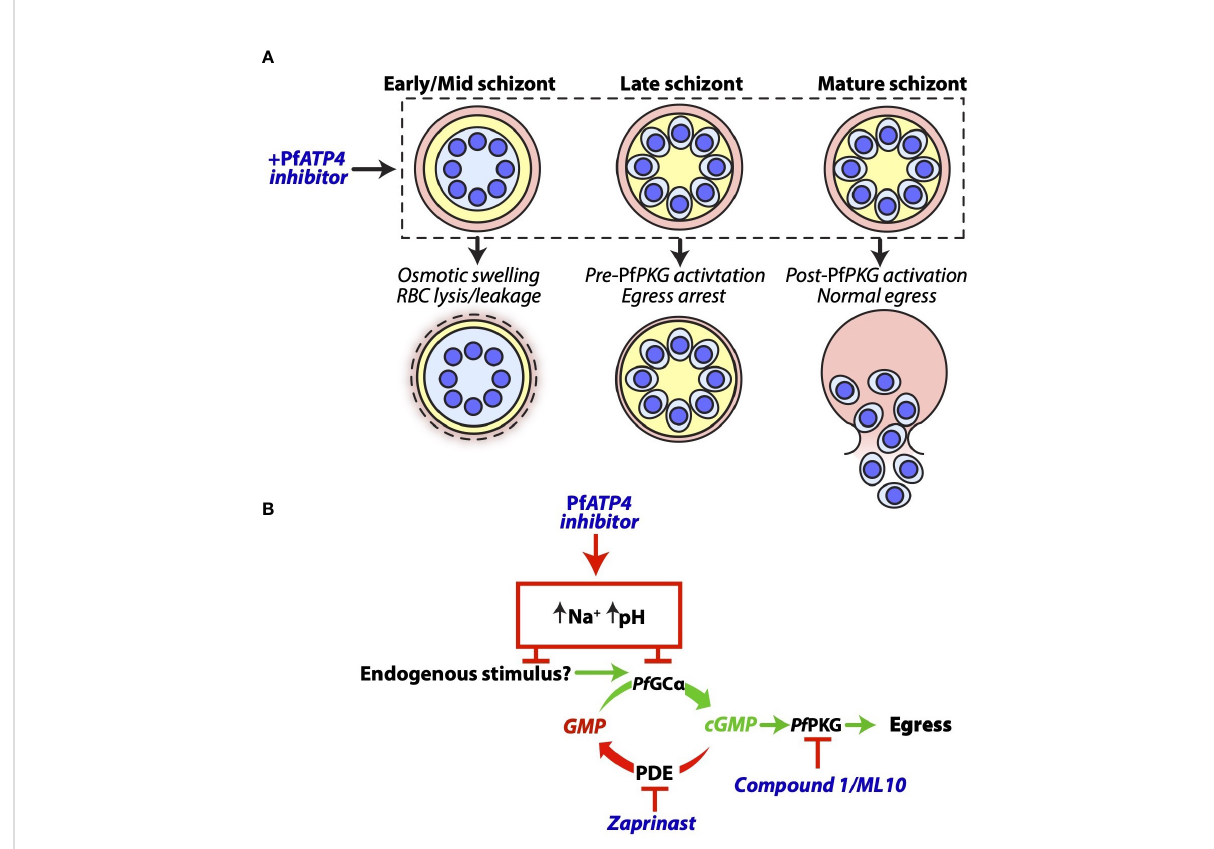
FIGURE 8 A proposed model for the effects of Pf ATP4 inhibitors in P. falciparum schizonts. (A) The outcomes of Pf ATP4 inhibition differ according to schizont age. Pf ATP4 inhibitors cause early- to mid-stage schizonts to accumulate Na + and osmotically swell. This results in lysis or leakage of host RBCs and therefore the release of nanoluciferase into the culture medium. When administered to late schizonts, Pf ATP4 inhibitors arrest egress without inducing substantial lysis or leakage of host RBCs. After cGMP elevation and the deployment of Pf PKG, mature schizonts are no longer susceptible to Pf ATP4 inhibitors and egress can proceed in the presence of these compounds. (B) Pf ATP4 inhibitors act upstream of the cGMP/ Pf PKG checkpoint to inhibit egress. During merozoite development, intra-parasitic cGMP levels are stabilised by the opposing activities of guanylyl cyclase a ( Pf GC a ) and phosphodiesterases (PDEs) An as-yet unidenti fi ed endogenous stimulus induces the functional upregulation of Pf GC a in late schizonts, resulting in cGMP elevation and Pf PKG activation. A PDE inhibitor, zaprinast, prevents cGMP degradation and therefore induces cGMP elevation and egress without the requirement for an increase in the rate of cGMP production, thereby obviating the need for the endogenous egress stimulus. Co-administration of zaprinast overcomes the egress-inhibitory effect of Pf ATP4 inhibitors. This supports a model wherein Pf ATP4 inhibitors block egress by preventing the functional upregulation of Pf GC a